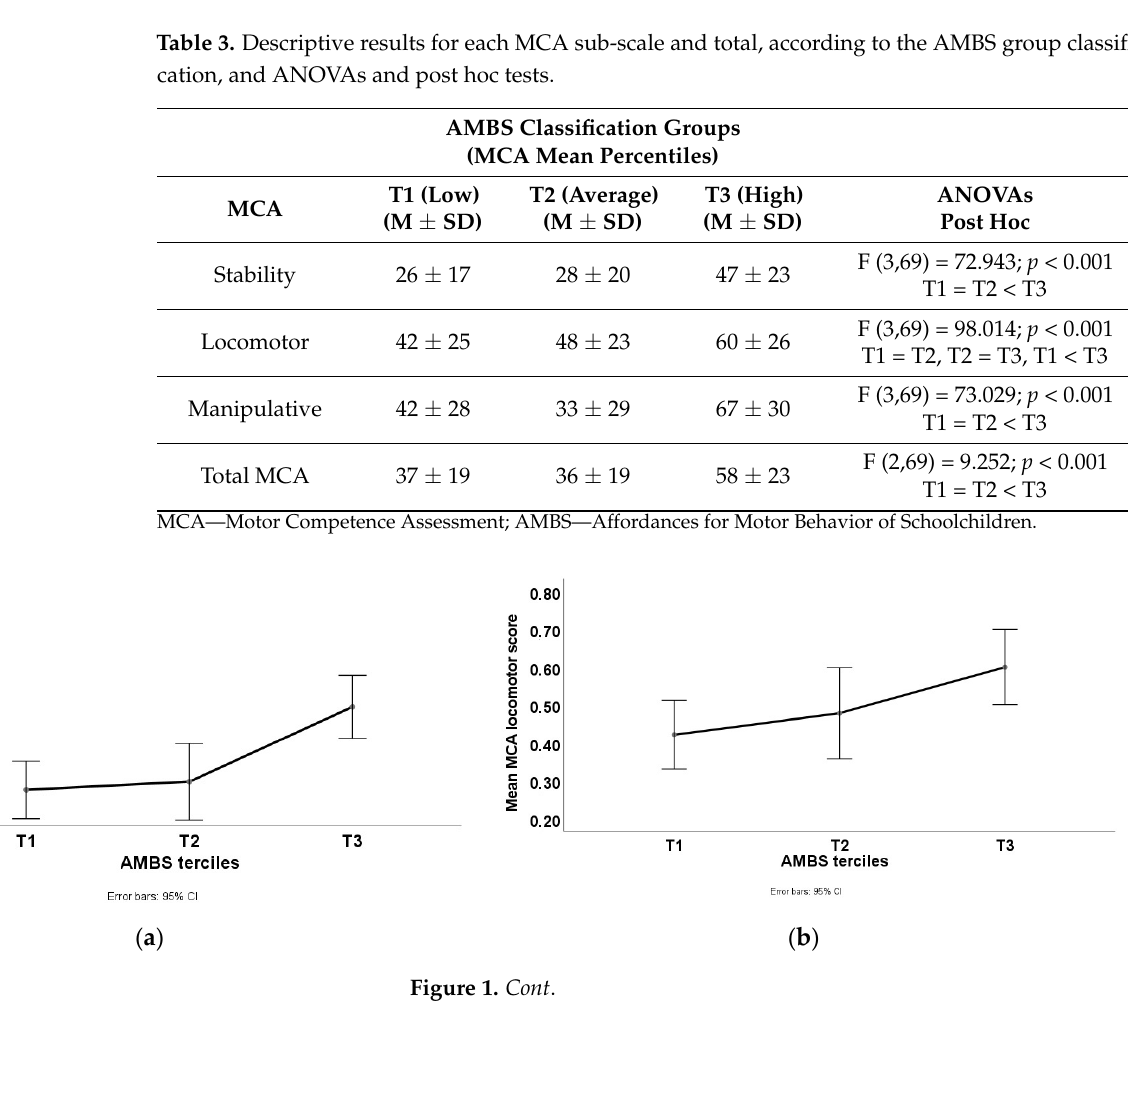
Table 2. Correlation between the MCA (sub-scales and total) and AMBS (sub-scales and total).